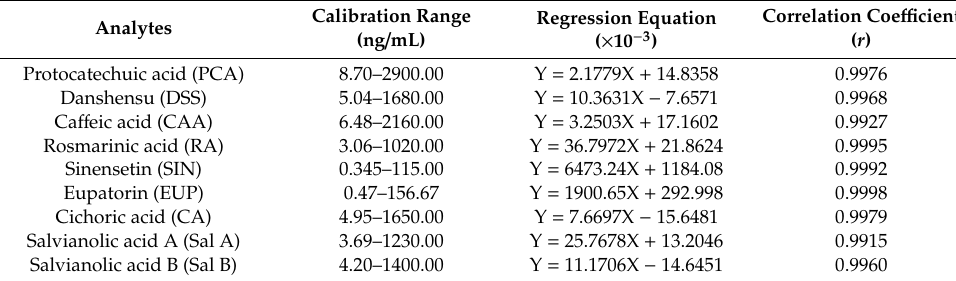
Table 1. Linearity data of the nine analytes in rat plasma.